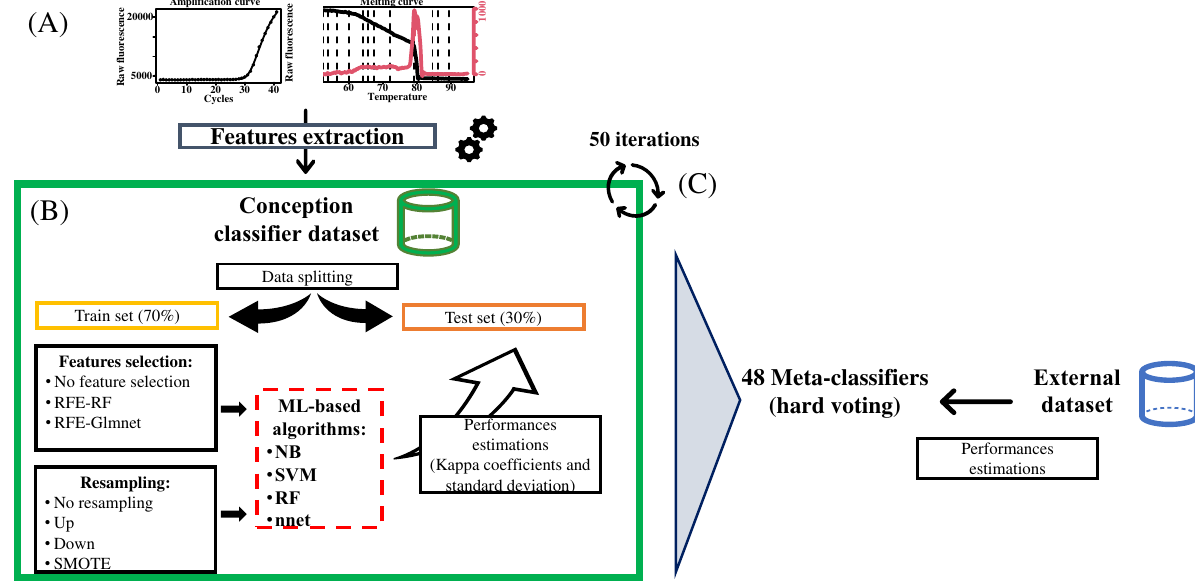
Figure 4. Pipelines for classifiers development and estimation of performances with the external dataset in three steps ( A , B and C ). ( A ) Extraction 14 features from amplification and melting curves using the R packages 25–27 ; splitting the conception classifier dataset (345 IDqPCR) into train and test datasets ( B ) Conception of classifiers (NB for Naive Bayes, SVM for Linear Support Vector Machine, RF for Random Forests and nnet for single-hidden-layer Neural NETwork with several pipelines: (i) selection of features using Recursive Feature Elimination (RFE) coupled to Random forests (RF) or Logistic Regression (Glmnet) or without selection variable method. (ii) different resampling methods (Up, Down or SMOTE 30 ) or no resampling method. The steps ( A ) and ( B ) were repeated with 50 iterations using a random loop and generated 2400 classifiers ( C ) Performances of 48 meta-classifiers grouped by Machine Learning algorithm, resampling, selection variable methods and based on hard voting method were estimated on the external dataset (389